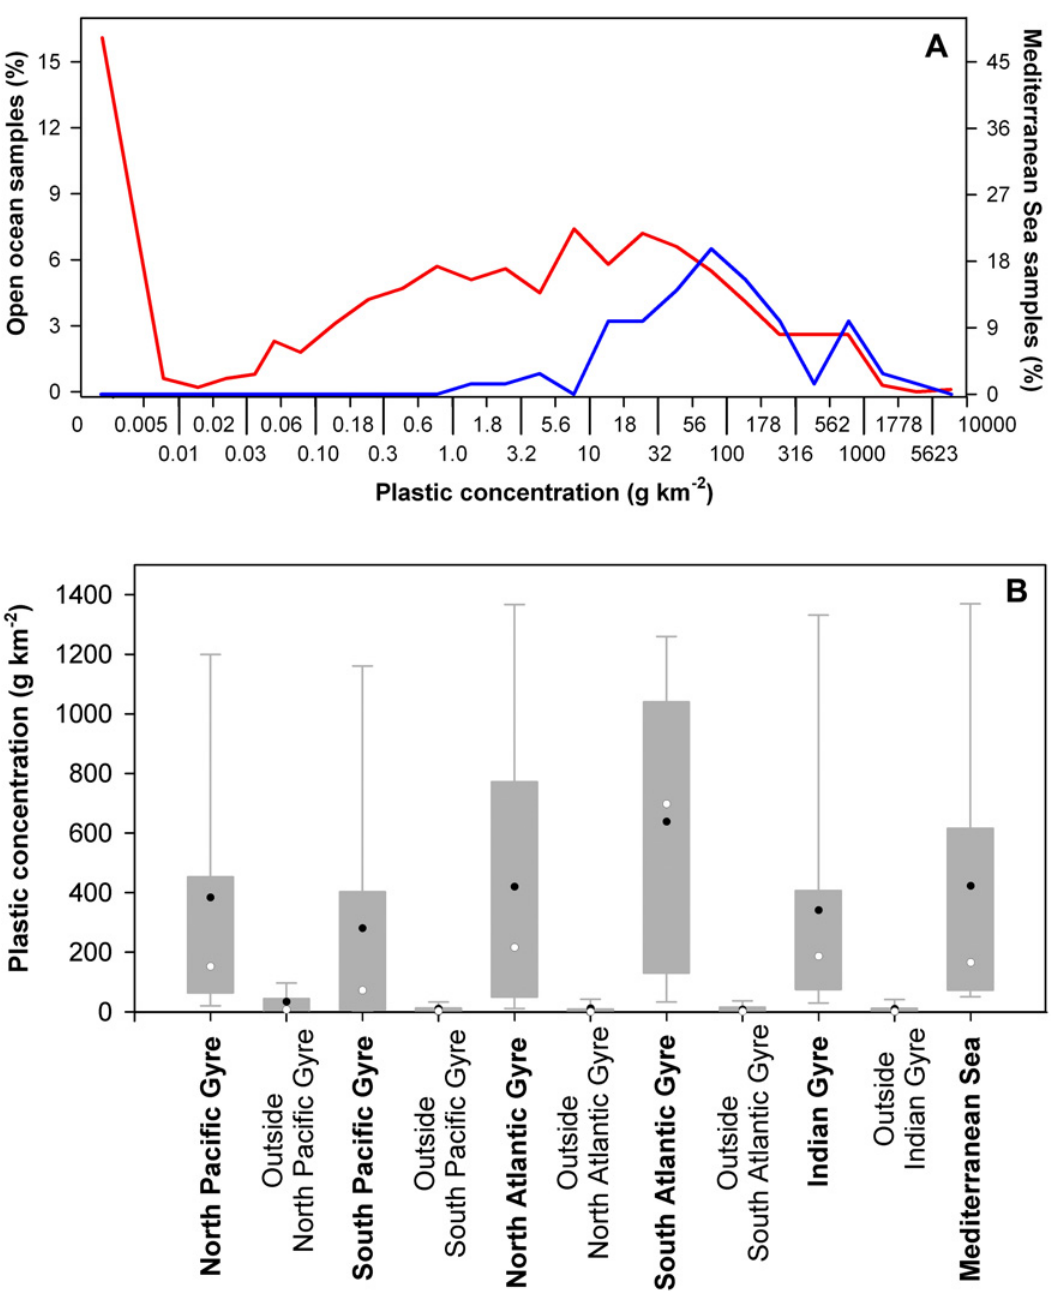
Fig 3. Ranges of surface plastic concentrations measured in the Mediterranean Sea, and reported for the open ocean. A) Frequency distribution of the measurements of plastic concentrations in the Mediterranean Sea ( n = 72) and in the global ocean ( n = 1760). Mediterranean measurements (blue line) are from the present study and ref. [20, 21]; ocean measurements (red line), including the five plastic accumulations in the subtropical gyres, were compiled from ref. [1 – 5, 10, 11]. All these data are mapped in Fig. 2. Size limits of the bins, shown in the horizontal axis, followed a 2.5-log series of plastic concentration (in g km 2 ). B) Surface plastic concentrations measured in the Mediterranean Sea, and reported for the inner accumulation zone of the five subtropical gyres (dark gray areas in Fig. 2) [1 – 5]. Ranges of concentrations outside the convergence zone of each subtropical gyre (white areas in Fig. 2) are also shown for comparative purposes. The boundaries of the boxes indicate the 25th and 75th percentiles, the whiskers above and below the boxes indicate the 95th and 5th percentiles, and the black and white dots mark mean and median respectively. All data in this analysis include correction by wind